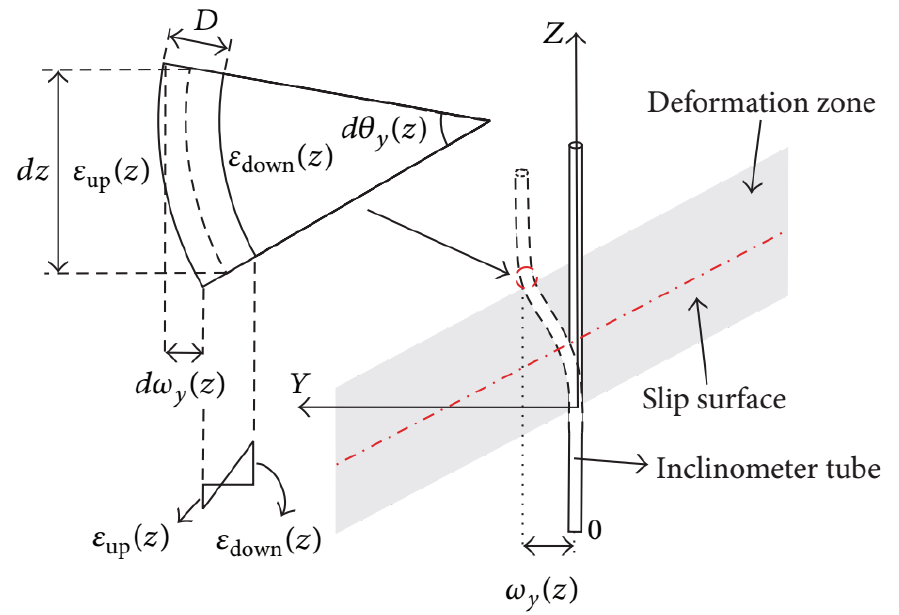
Figure 18. The principle of an optical fibre inclinometer for displacement calculation (reproduced with permission from [214]).